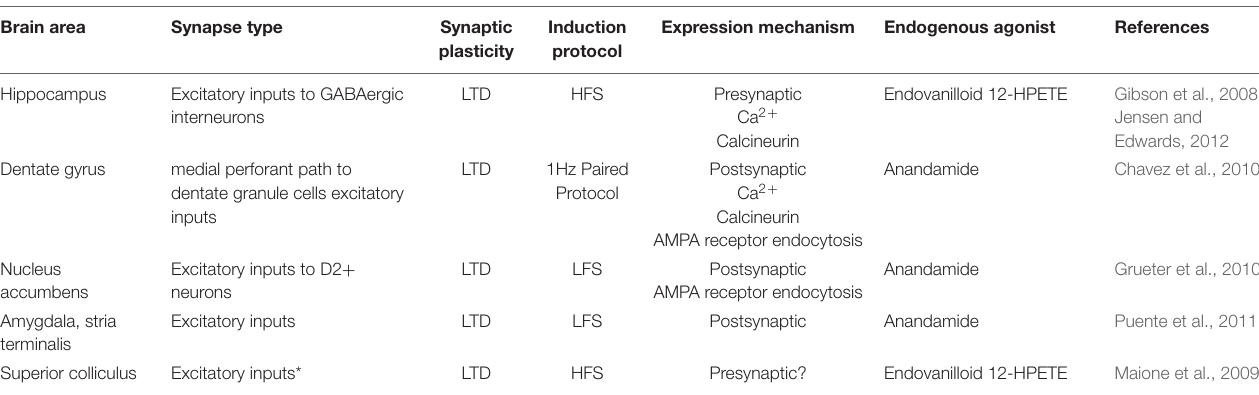
FIGURE 1 | Mechanisms described for TRPV1-mediated plasticity at central synapses. Glutamate release during synaptic stimulation activates Gq-coupled mGluRs, leading to the activation of phospholipase C (PLC) and downstream calcium-regulated enzymes, which likely triggers the biosynthesis of lipids including 12-HPETE (presynaptic TRPV1-LTD, left ) or AEA (postsynaptic TRPV1-LTD, middle ), two endocannabinoid/endovanilloid known to activate TRPV1 receptors. At presynaptic terminals, activation of TRPV1 on plasma membrane or intracellular compartments (IC) leads to a calcium (Ca 2 + )-dependent long-term depression of synaptic vesicle release, whereas when located at postsynaptic compartments, TRPV1 activation promotes a long-lasting, clathrin- and dynamin (Dyn)-dependent endocytosis of AMPA receptors. Notably, stimulation of calcium-sensitive phosphatase calcineurin (CaN) resulting from TRPV1 activation is likely to be a common mechanism to promote both pre and postsynaptic long-term changes of synaptic efficacy. TRPV1 channels are also expressed in glial cells ( right ), where its activation can modulate synaptic efficacy presumably through the production and release of inflammatory mediators through microglia-derived extracellular vesicles (EVs) or by Ca 2 + -dependent release of gliotransmitters from astrocytes. TABLE 1 | TRPV1-mediated synaptic plasticity in the mammalian